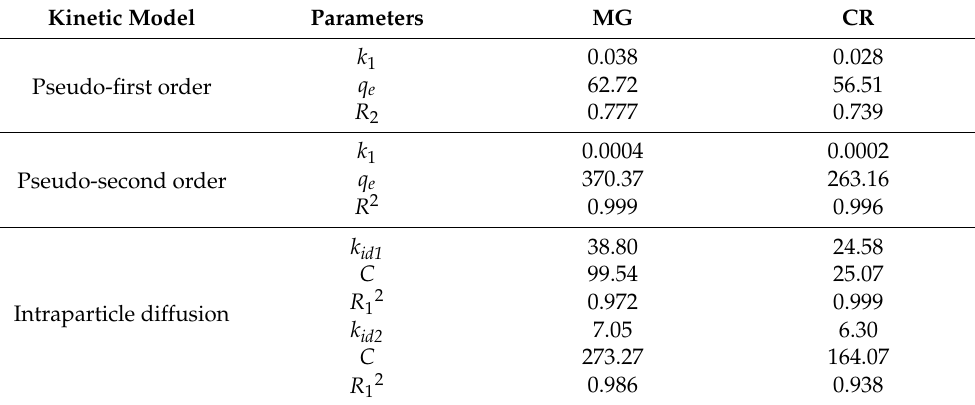
Table 4. Adsorption kinetics constant and parameter